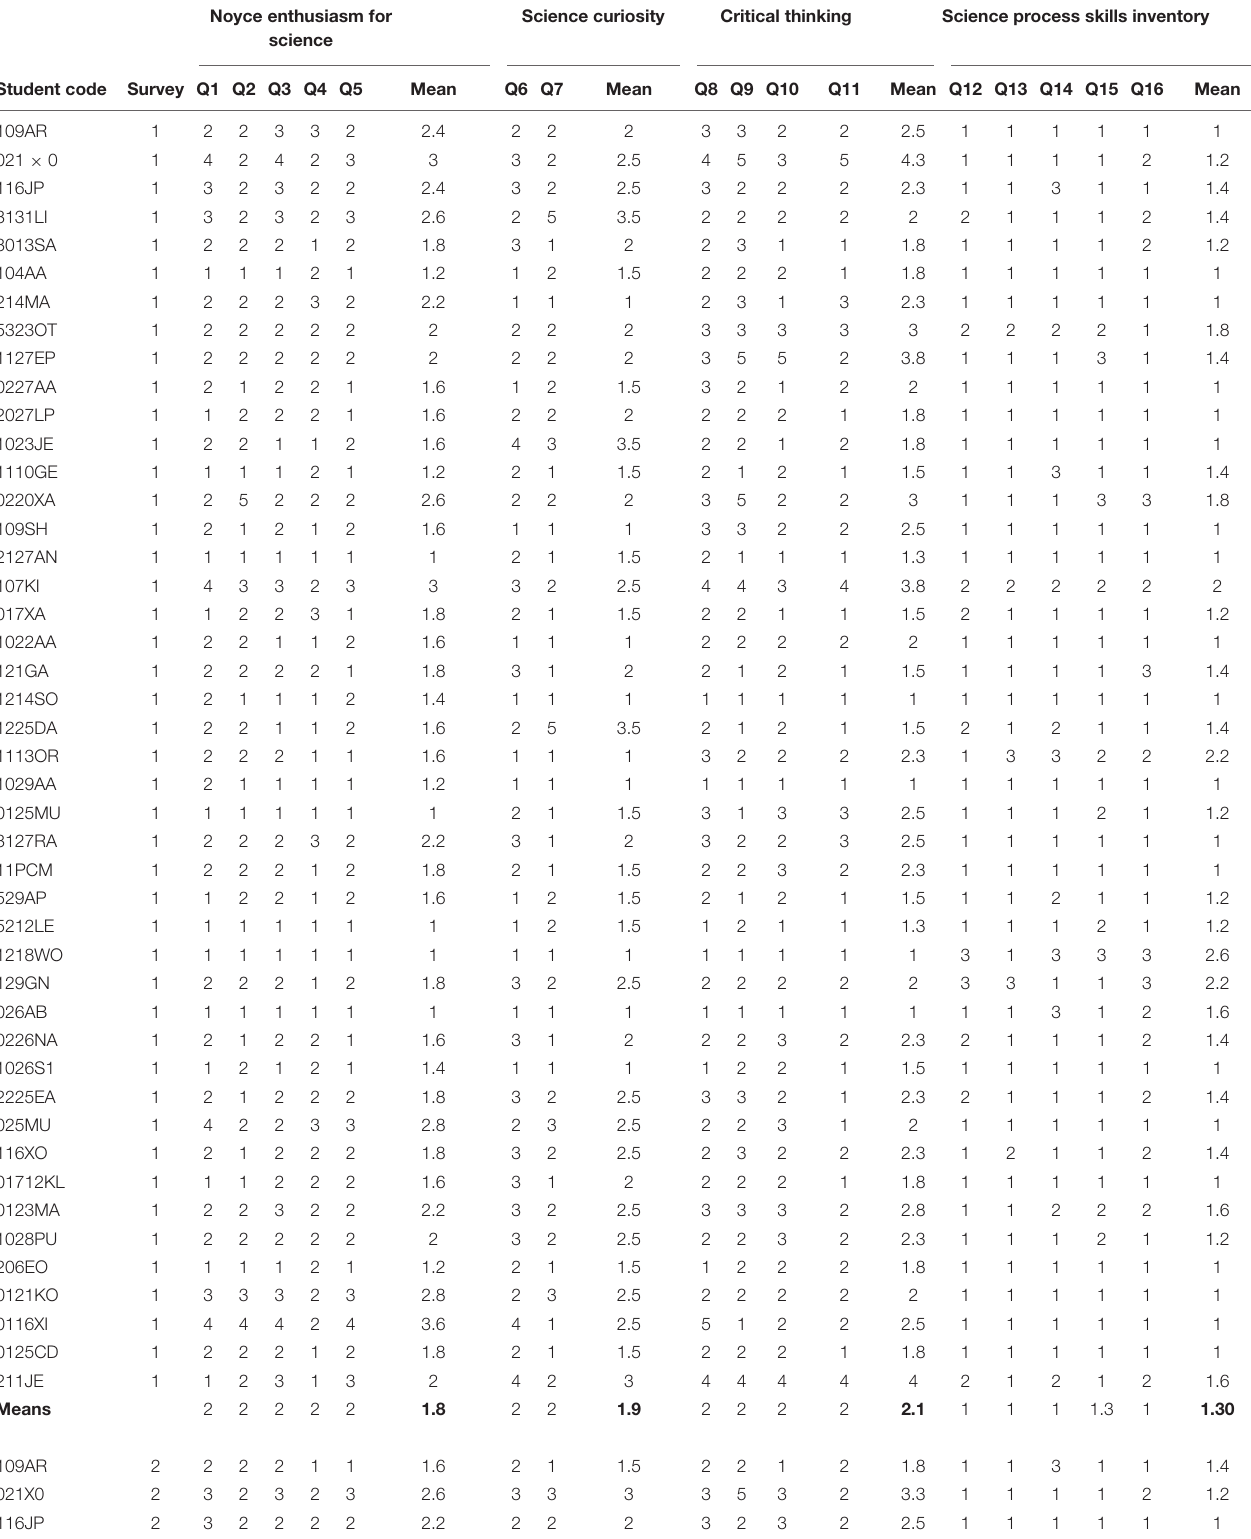
TABLE 3 | Numerical participant survey responses with mean values pre and post